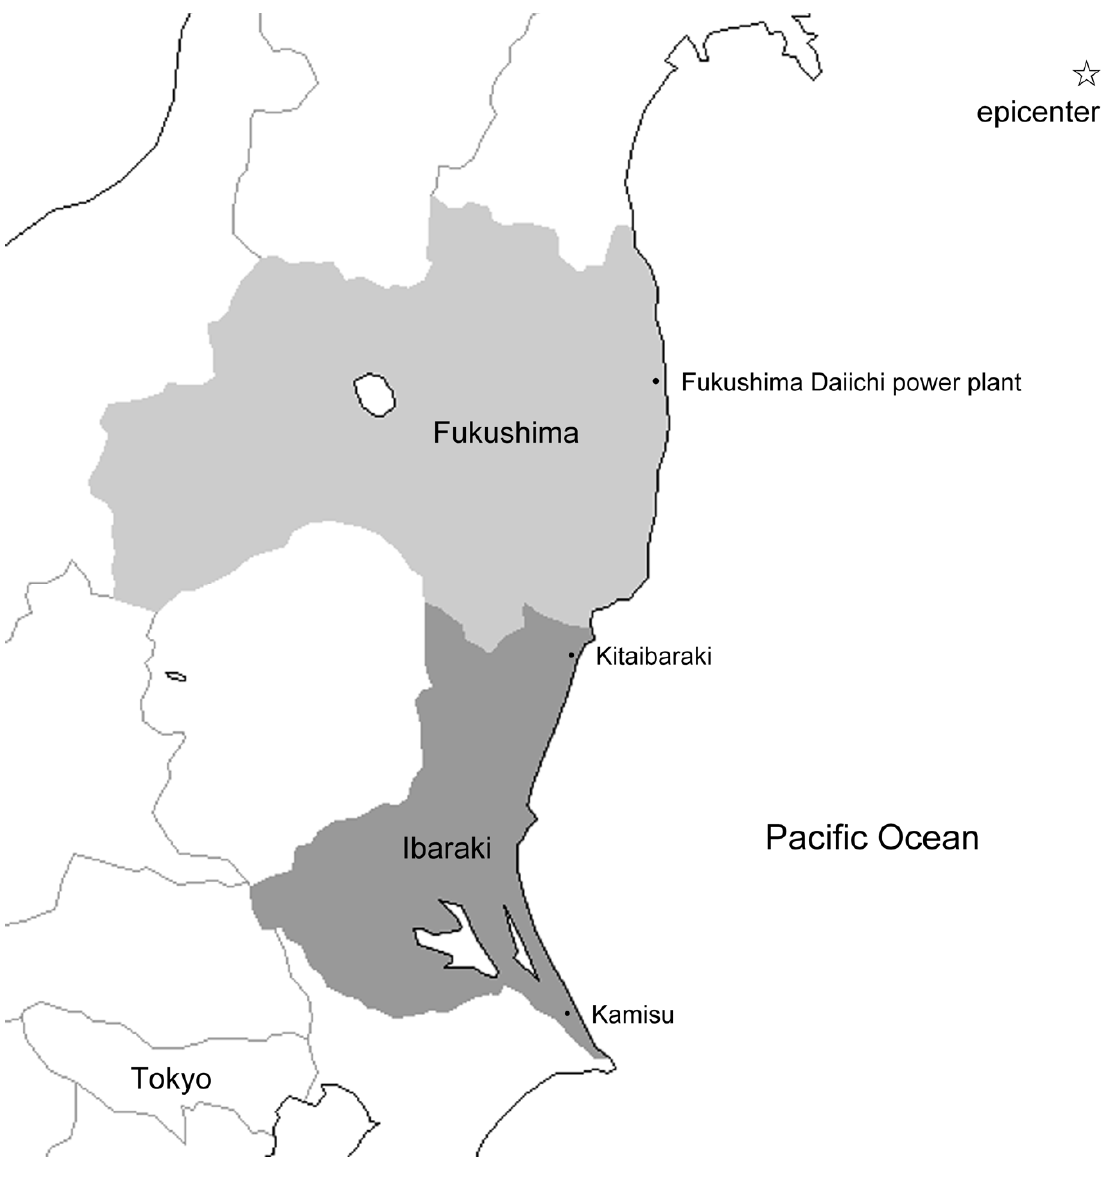
Figure 1. Area map. Table 1. Damage from the Great East Japan Earthquake.